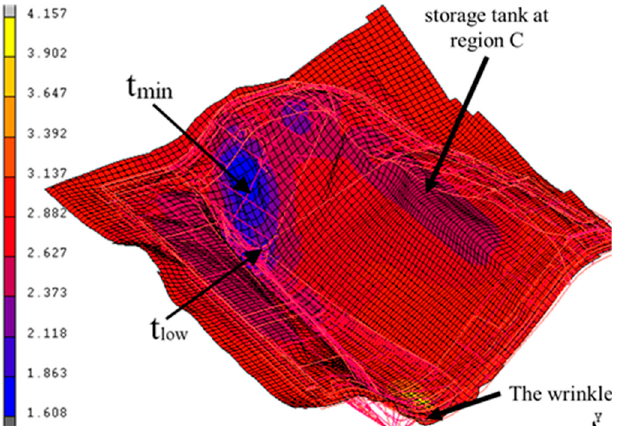
Figure 7. Thickness distribution of the drawing during the final forming process.